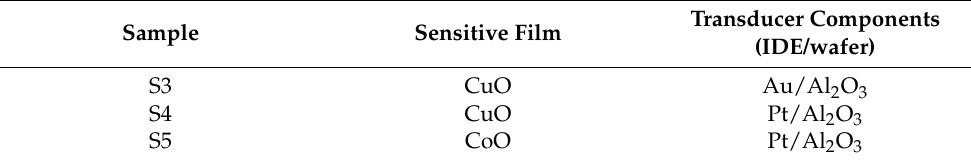
Table 5. The obtained sensors and their composition, after final thermal treatment (400 ◦ C, for 10 min), from Ref.